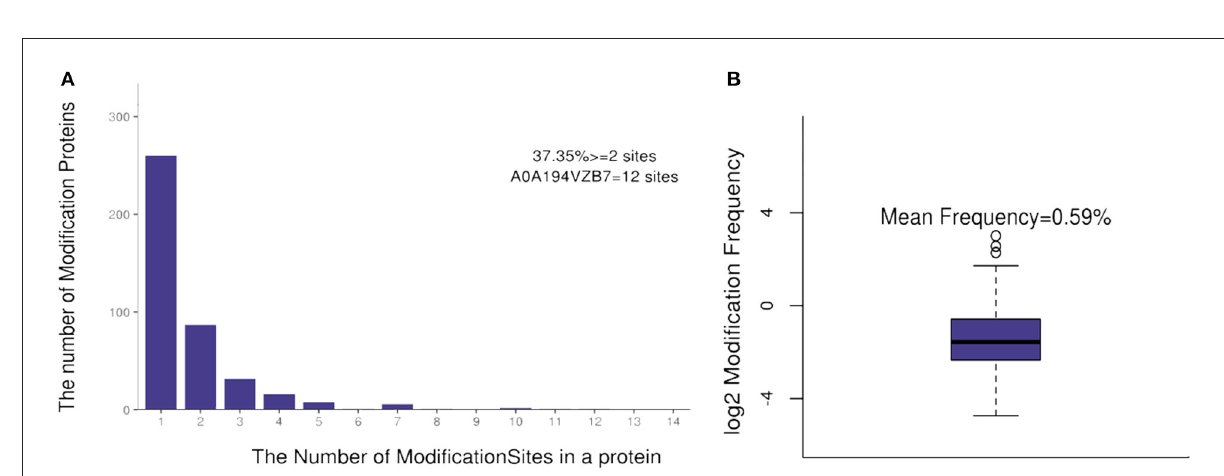
FIGURE1 The distribution of acetylation sites in a protein (A) and the modification sites frequency (B) .